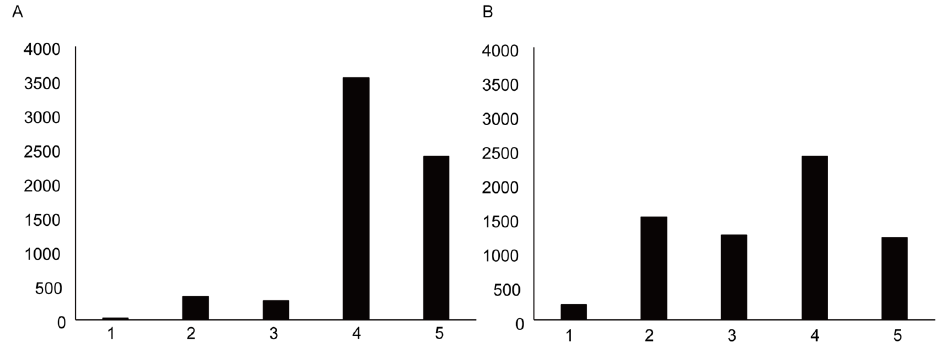
Figure 3. The distribution of the level of infection risk anxiety ( A ) and the level of vaccination risk anxiety ( B ) of the participants: (1) None, (2) Not very anxious, (3) Neutral, (4) Somewhat anxious, (5) Very anxious. Table 2. Websites used by participants to obtain information on COVID-19 and vaccines a .